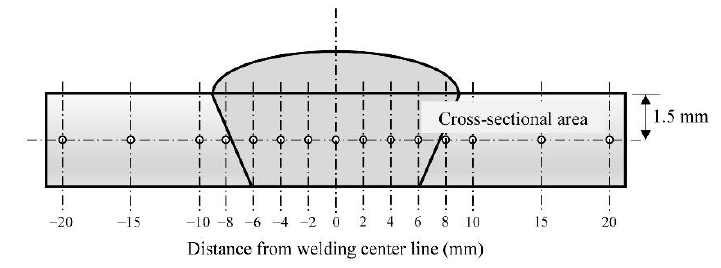
Figure 6. Position for measuring Vickers microhardness.